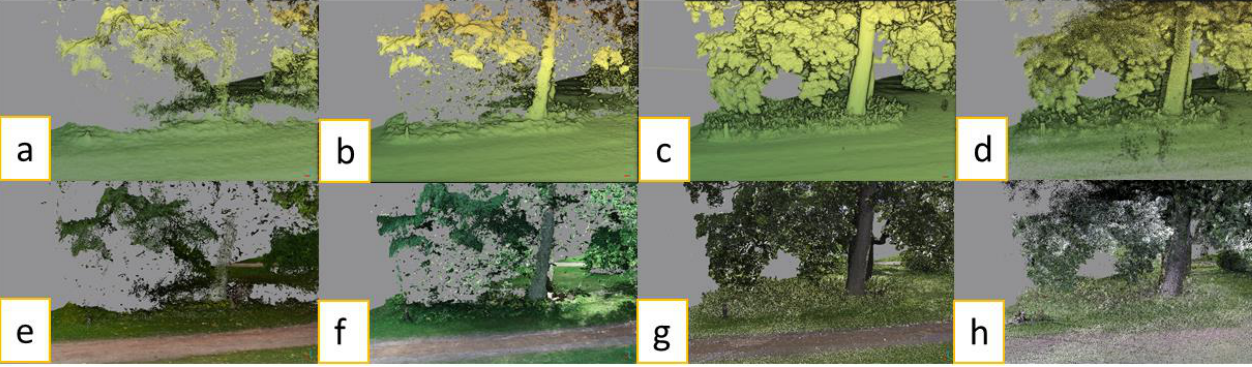
Figure 10. Comparison of point clouds for natural ground vegetation. In the top row, the point clouds are colored with the height ramp, and in the bottom row with RGB colorization.